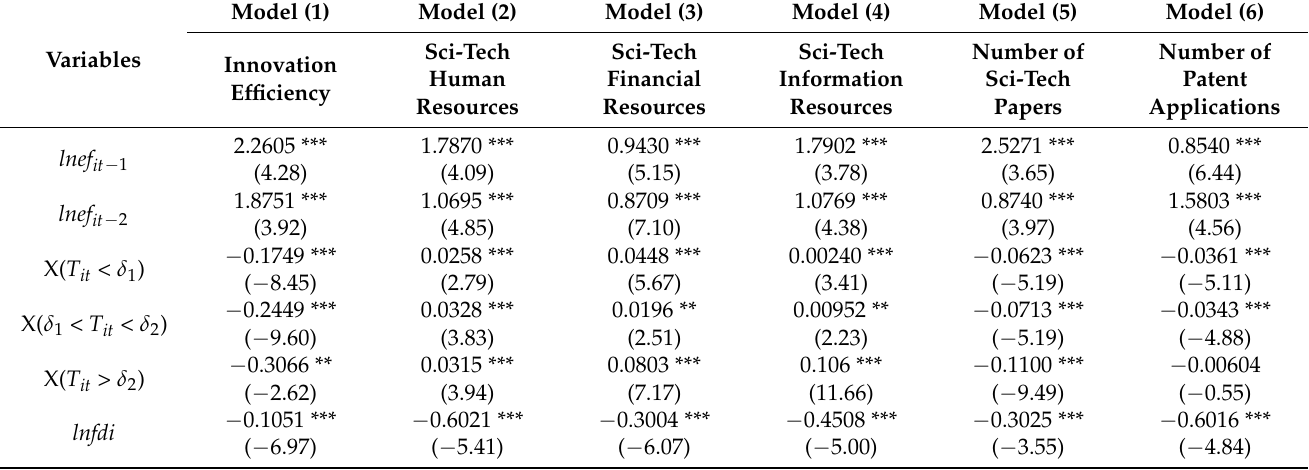
Table 6. Threshold model parameter estimation results of innovative